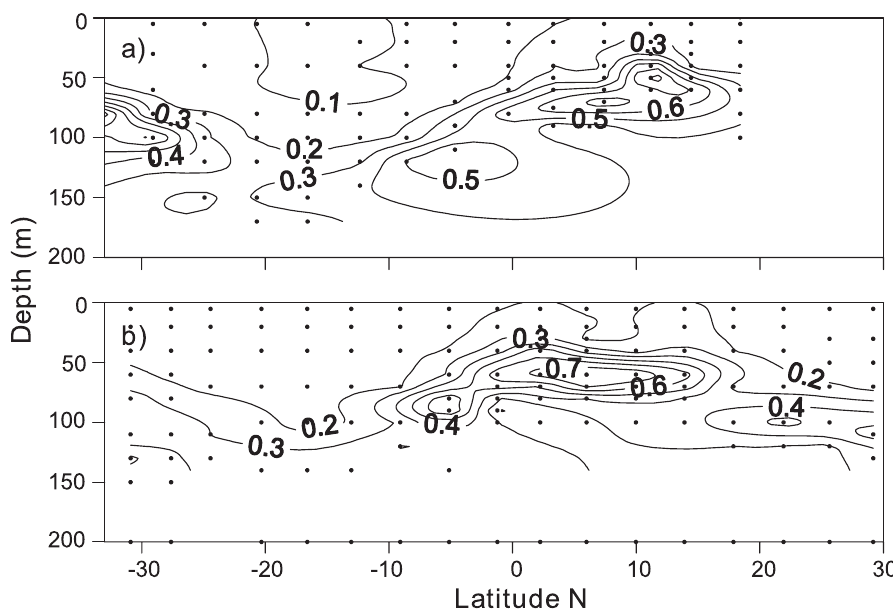
Fig . 2. – Latitudinal distribution of total chl a (mg m -3 ). a) Trynitrop 2007; b) Trynitrop